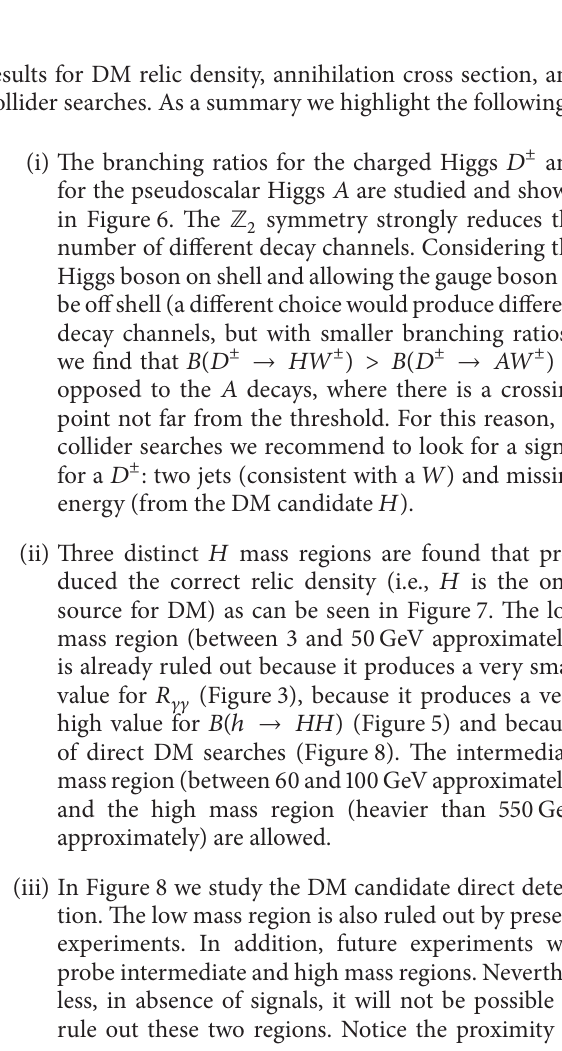
Figure 7: Relic density for 𝐻 as a function of its mass 𝑚 𝐻 (a), and annihilation cross section for 𝐻 also as a function of its mass 𝑚 𝐻 (b), for the same random scan of IHDM parameter space.